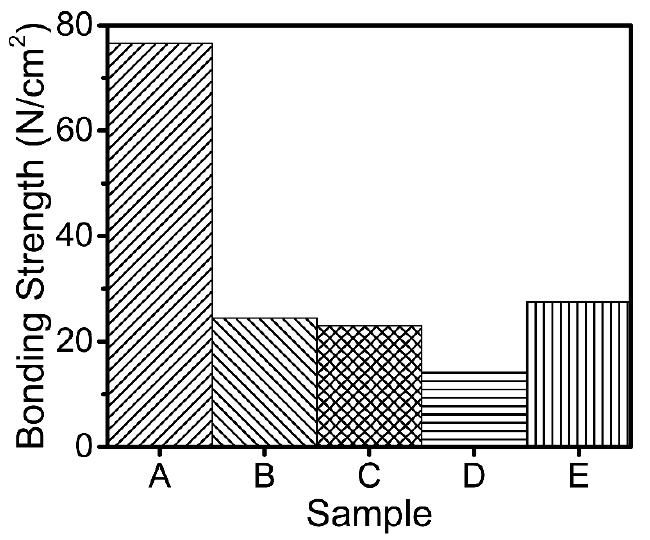
Figure 10. The adhesion strength of different LC-polymer composites: (A) The optimized sample in this work; (B) acrylate-based polymer-dispersed and stabilized liquid crystals (PD&SLC) doped with 5.0 wt.% ITO/SiO 2 nanocrystals reported by Xiao Liang et al. [14] ; (C) acrylate-based PD&SLC doped with 5.0 wt.% Cs x WO 3 /PVP nanorods [17] ; (D) acrylate-based polymer dispersed liquid crystals reported by Haonan Lin et al. [23] ; (E) acrylate-based polymer dispersed liquid